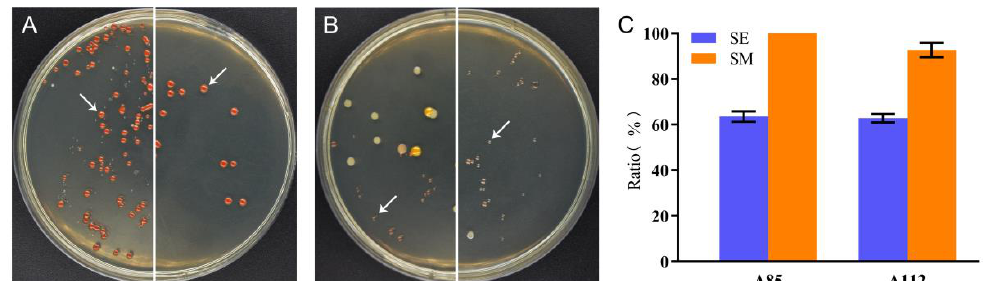
Figure 5. The CFU assay for studying the microbial composition in the open fermentation. The Figure A85 and A112 at the highest PHA yields (4 and 5 days, respectively) were used for the CFU analysis. The left half-circles in ( A , B ) were the fermented broths of the SE medium, and the right half-circles were the fermented broths of the SM medium (with the addition of 0.5% glucose). The white arrows indicate target strains A85 ( A ) and A112 ( B ), respectively. More than 20 randomly colonies from each plate were 16S rDNA analysis in the open fermentation. The ratio of the dominated strain was calculated by divided the number of the target colonies to the total number of all chose colonies ( C ). The blue and orange columns indicated the SE medium and SM medium, respectively. All the data are presented as means of duplicates with their standard errors.